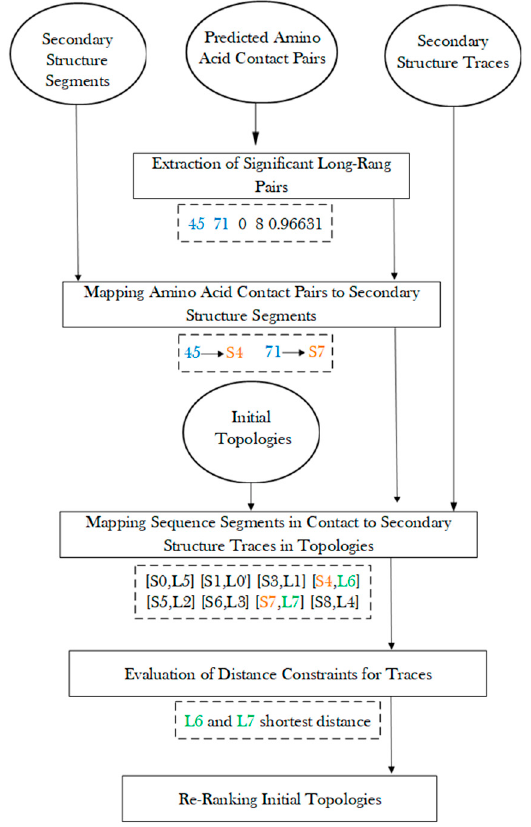
Figure 5. Evaluation of initial topologies using amino acid contact pairs.